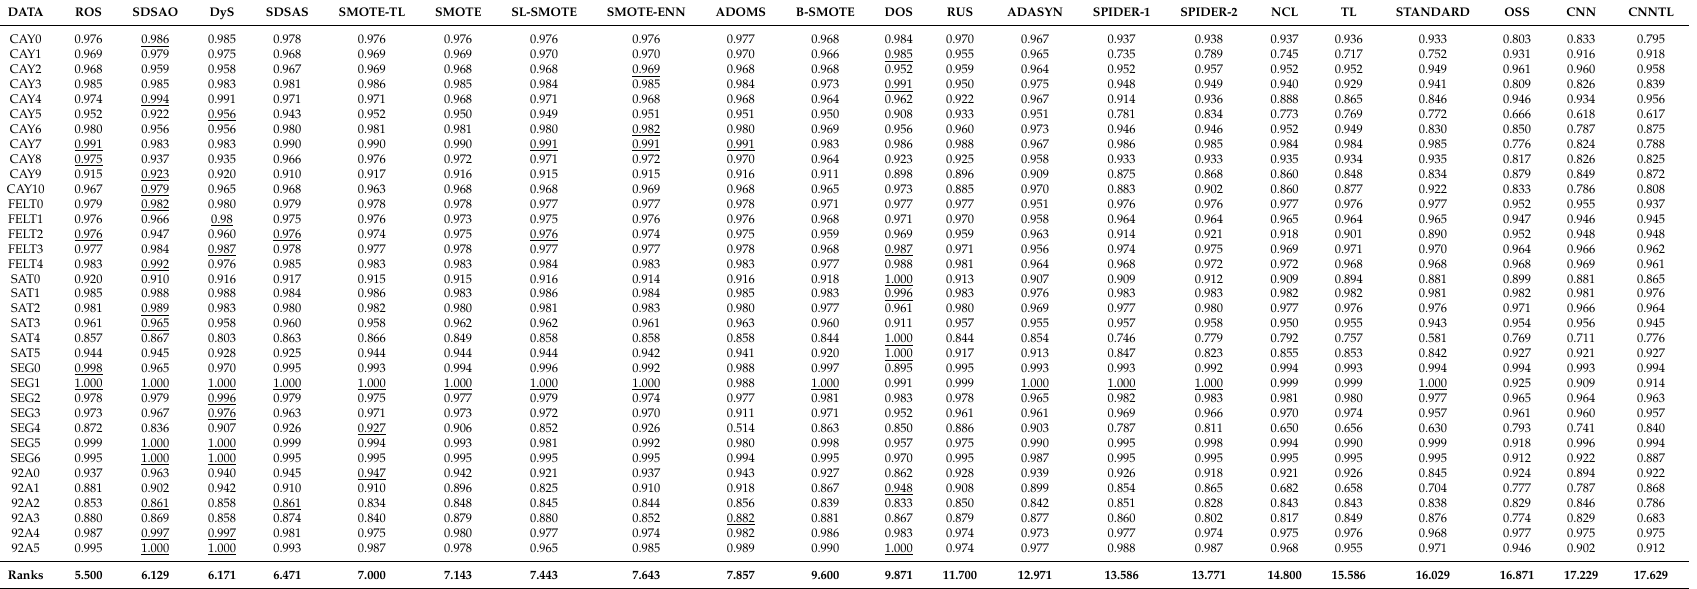
Table 2. Back-propagation classification performance using the Area Under the receiver operating characteristic Curve (AUC) . The results represent the averaged values between ten folds and the initialization of ten different weights of the neural network. The best values are underlined in order to highlight them. ROS, Random Over-Sampling; SDSAO, Selective Dynamic Sampling Approach using ROS; DyS, Dynamic Sampling; SDSAS, Selective Dynamic Sampling Approach applying SMOTE; SMOTE-TL, SMOTE and TL;SMOTE, Synthetic Minority Over-sampling Technique; SL-SMOTE, Safe-Level SMOTE; SMOTE-ENN, SMOTE and Editing Nearest Neighbor (ENN) rule; ADOMS, Adjusting the Direction Of the synthetic Minority clasS method; B-SMOTE, Borderline-SMOTE; DOS, Dynamic Over-Sampling; RUS, Random Under-Sampling; ADASYN, Adaptive Synthetic Sampling; SPIDER 1 and 2, frameworks that integrate a selective data pre-processing with an ensemble method; NCL, Neighborhood Cleaning Rule; TL, Tomek links method; STANDARD, back-propagation without any pre-processing; OSS, One-Sided Selection method; CNN, Condensed Nearest Neighbor; CNNTL, Condensed Nearest Neighbor with TL (for more details see Sections 3 and